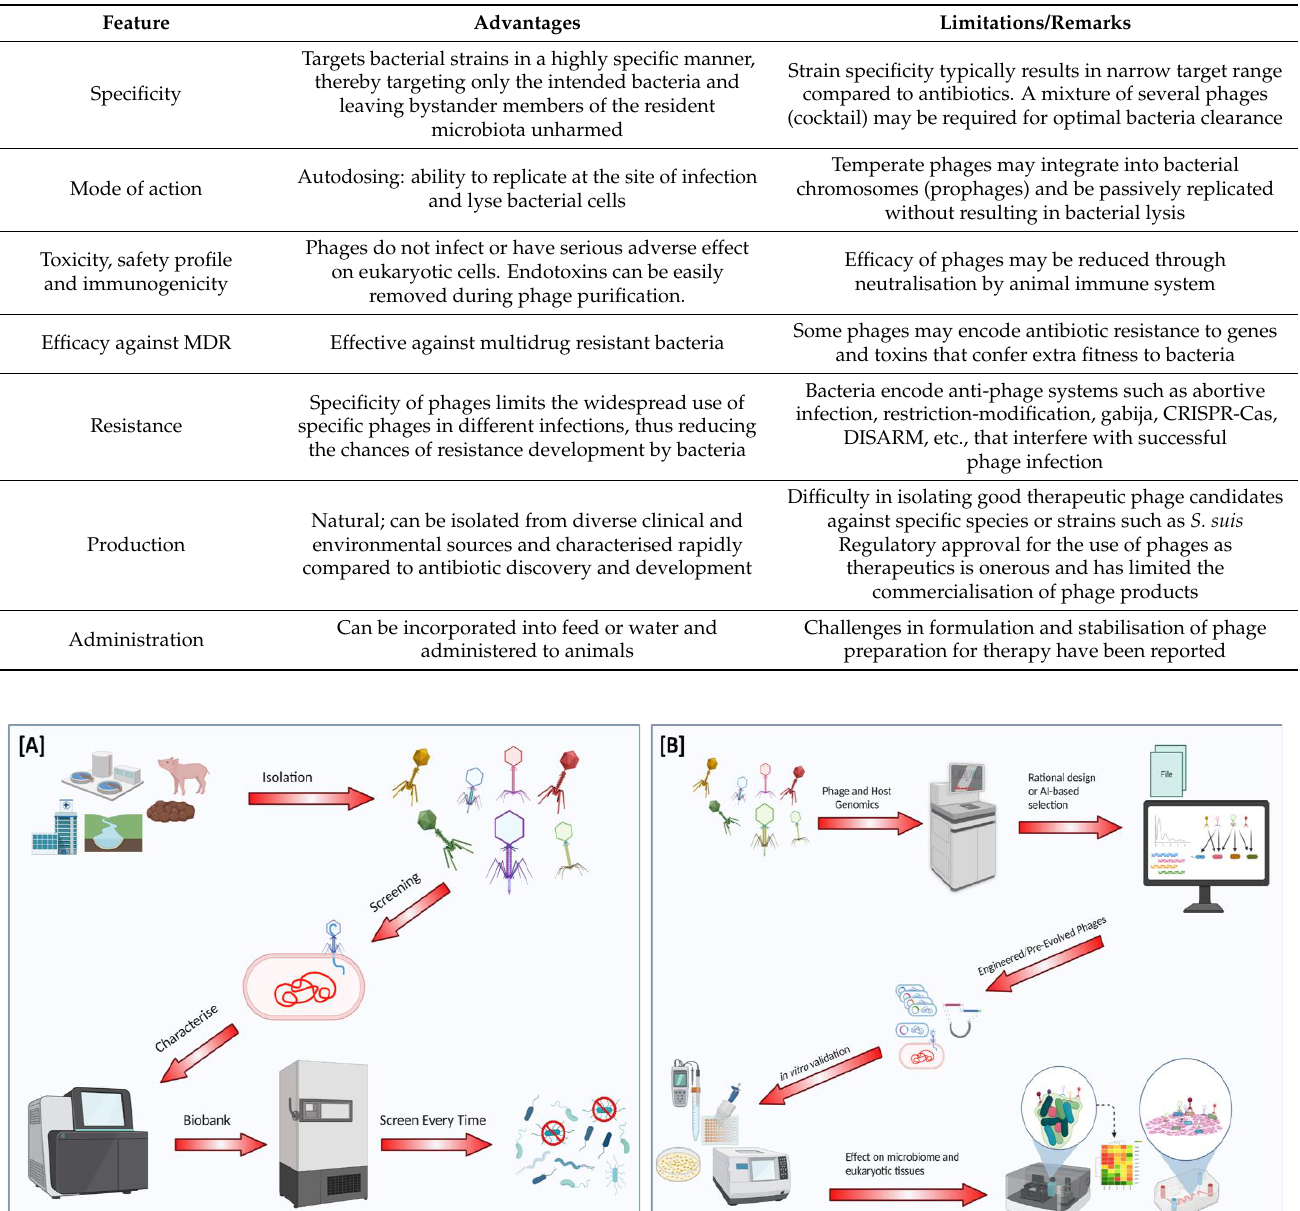
Table 2. Some applications of phages in human infections (2017 – 2022) .